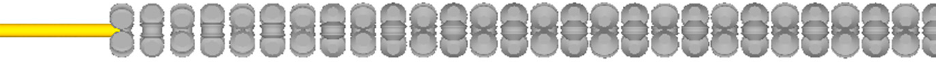
Figure 6. The finite element model of the 28-stand tension-reducing mill.